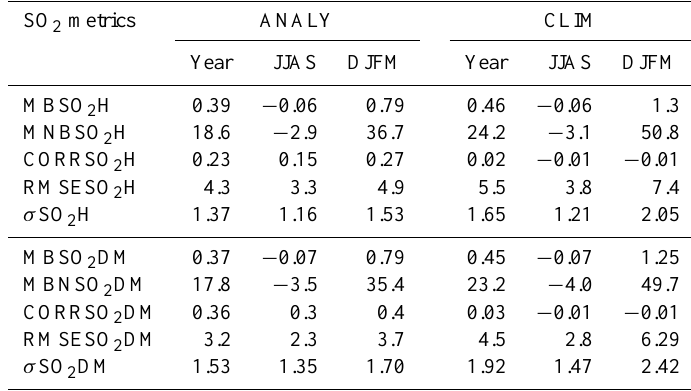
Table 8. Same as Table 6 for hourly value and daily mean SO 2 concentrations. SO 2